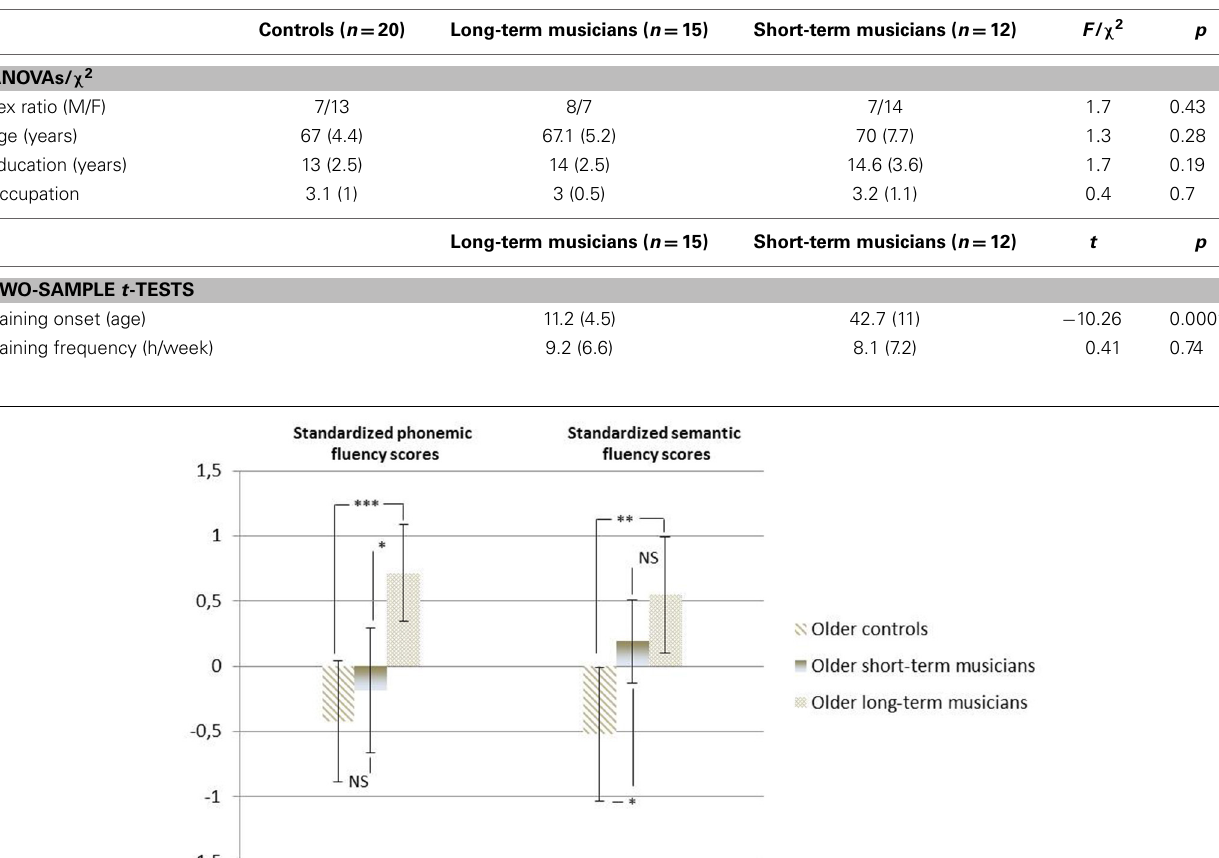
Frontiers in Aging